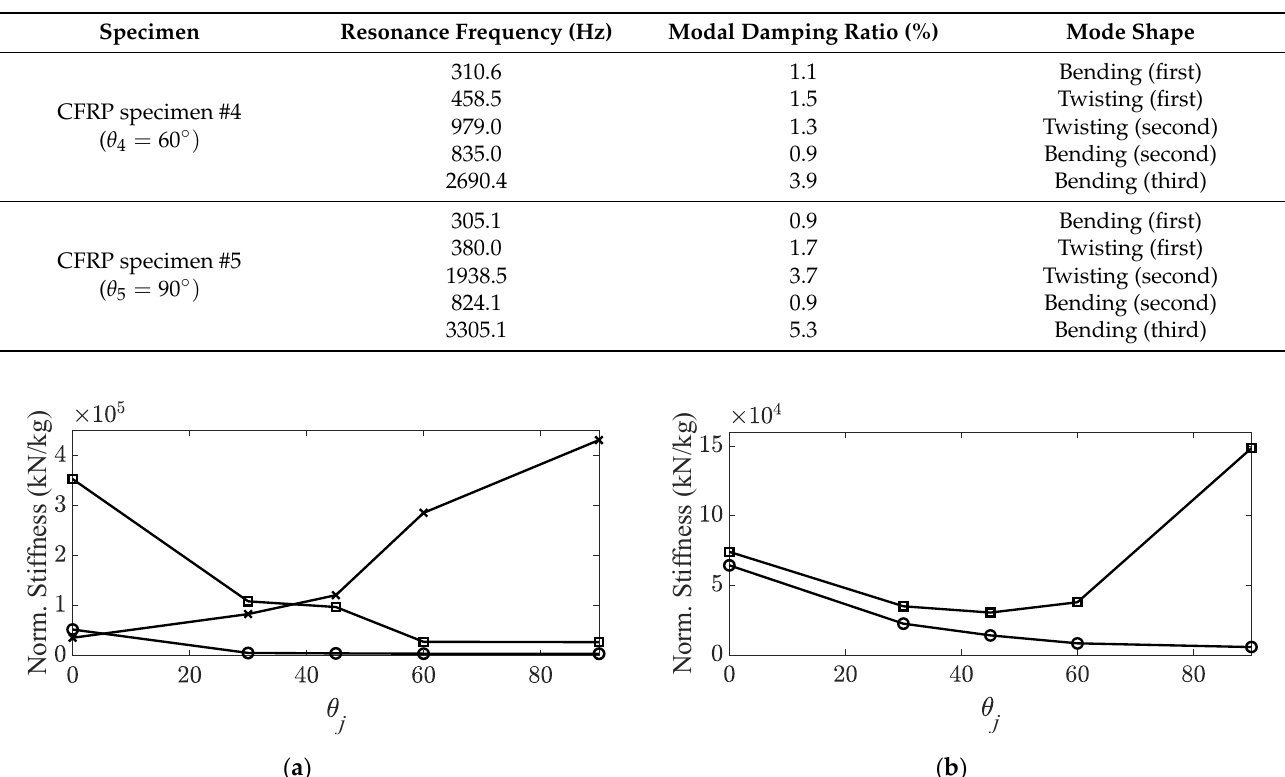
Figure 5. Variations in viscous damping coefficient according to carbon fiber angle: ( a )